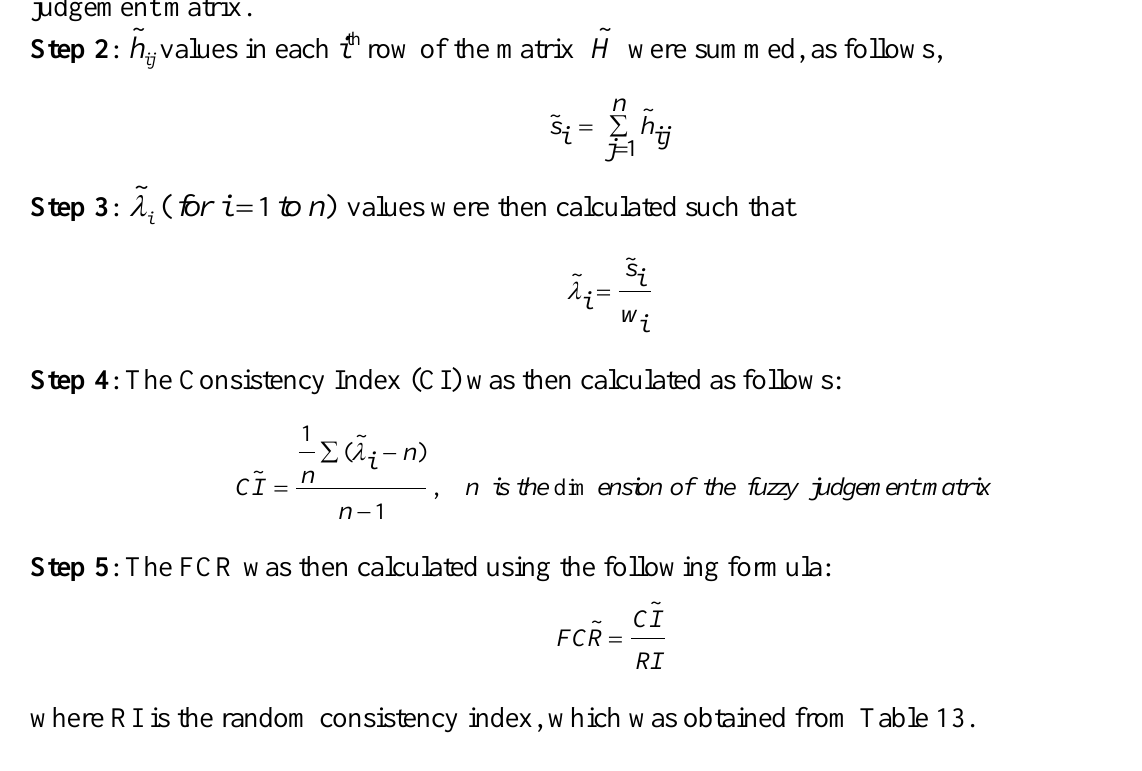
Table 13. Random Indices for Consistency